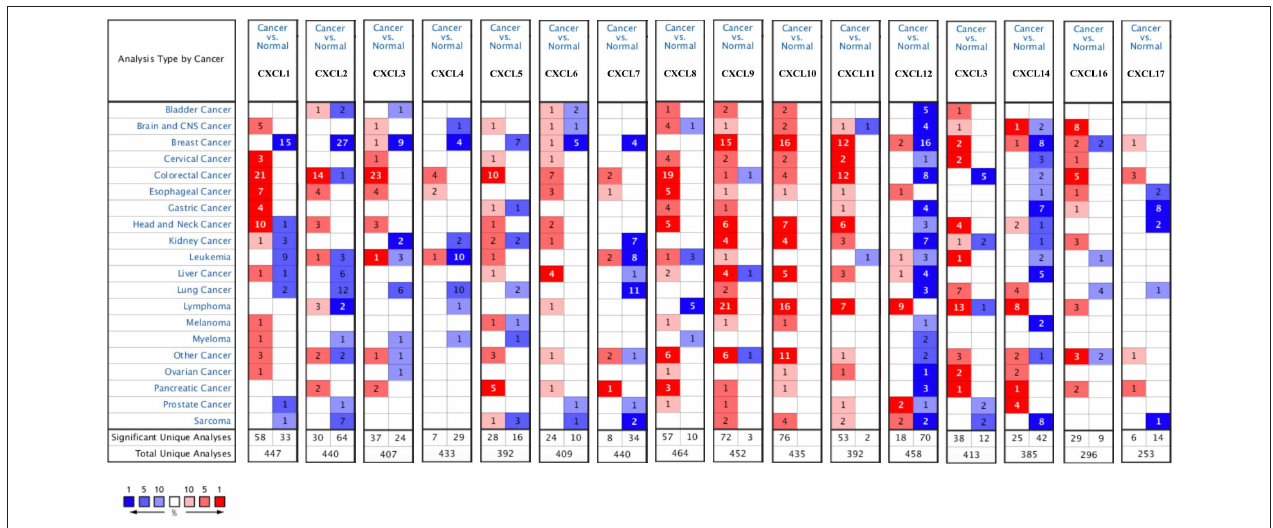
FIGURE 1 | mRNA levels of CXC chemokines in RCC (ONCOMINE). The figure shows the numbers of datasets with statistically significant mRNA over-expression (red) or downregulated expression (blue) of CXC chemokines.